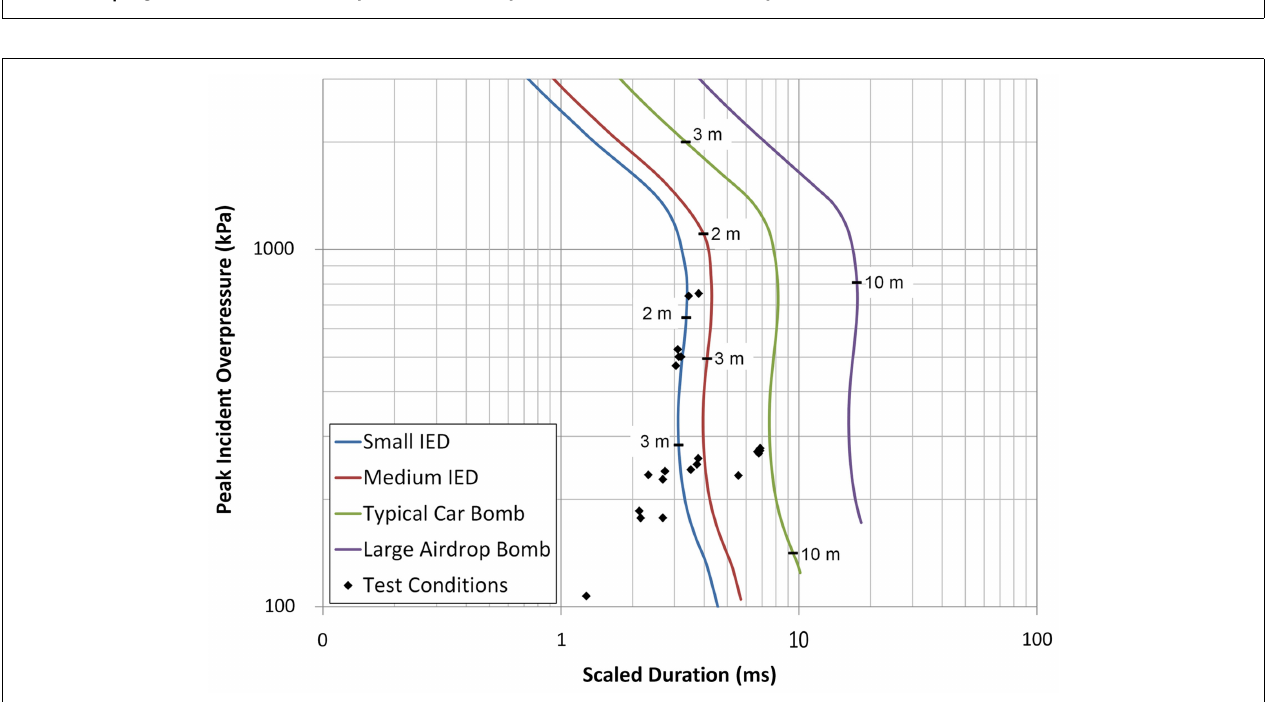
FIGURE 13 |The porcine test conditions plotted against the overpressure and duration conditions of realistic threats calculated using ConWep (Hyde, 2004).